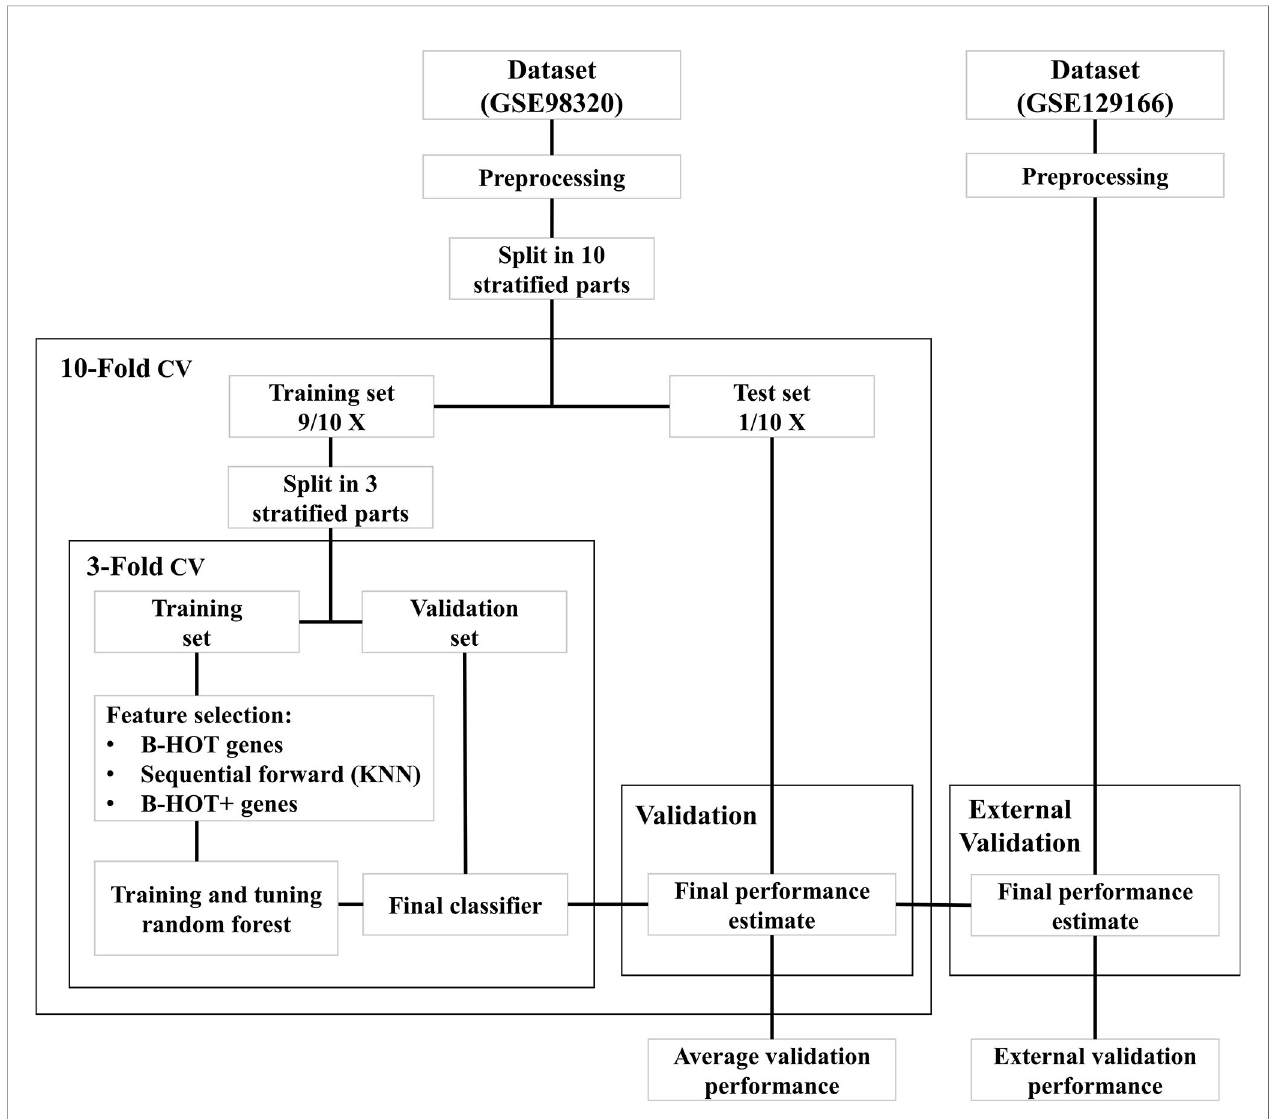
FIGURE 2 | Overview of model development work fl ow. B-HOT, Banff-Human Organ Transplant; CV, Cross-Validation; KNN, K-nearest